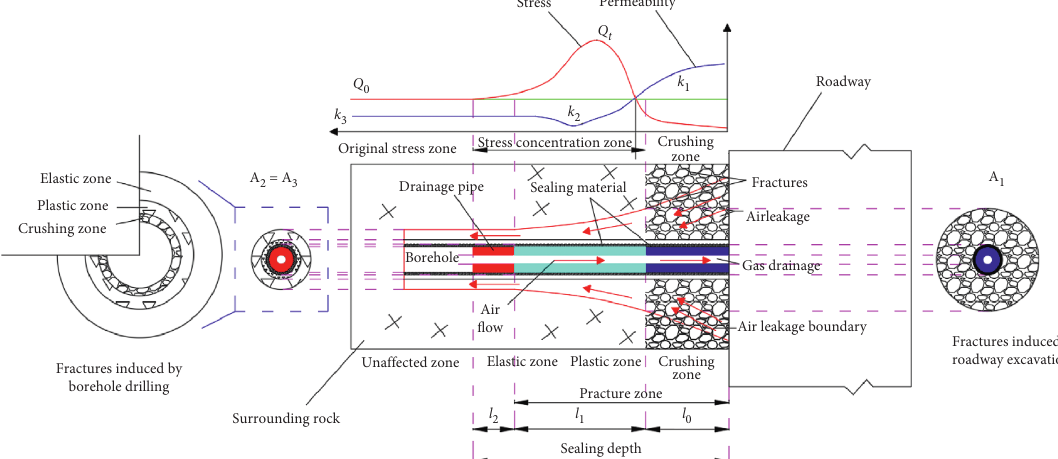
Figure 1: Distributions of stress and permeability in the surrounding rock of